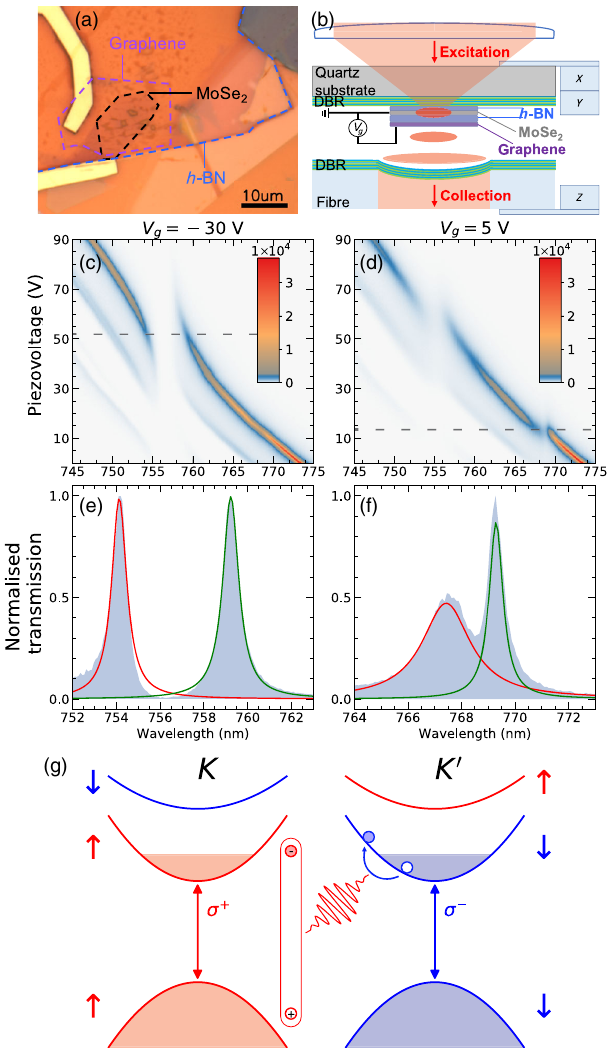
FIG. 1. Experimental setup and characterization of the sample. (a) Contrast-enhanced optical microscope image of the heterostruc- ture. The h -BN, graphene, and MoSe 2 layers are indicated by dotted lines. (b) Schematic of the sample inside the cavity. The hetero- structure sits on a flat dielectric mirror facing a fiber mirror which together form a cavity. The h -BNandgraphenelayer thicknesses are chosen such that the MoSe 2 lies in an antinode while the graphene lies close to a node of the cavity electric field. Applying a gate voltage between MoSe 2 and graphene provides electron density control. The cavity mode can be tuned in situ by a z -axis nano- positionerwhichcontrolsthecavitylength.Thesubstrateismounted on x - and y -axis nanopositioners which allow for in-plane trans- lation. (c),(d) White light transmission spectrum for gate voltages ¼ − 30 V and V ¼ 5 V, respectively. Nonperturbative cou- V g g pling between the cavity mode and optical resonances show up as anticrossings in the transmission spectrum. The faint lines originate from the higher-order cavity modes. (e),(f) Line cuts taken near the anticrossing [dashed lines in (c) and (d)] reveal the upper polariton (red) and lower polariton (green) resonances. (g) Schematic to illustrate the conduction and valence band structure and optical selectionrules ofmonolayer MoSe 2 closetothe K and K 0 points.An exciton in the K valley interacts with conduction band electron-hole pairs in the Fermi sea of the K 0 valley to form an intervalley